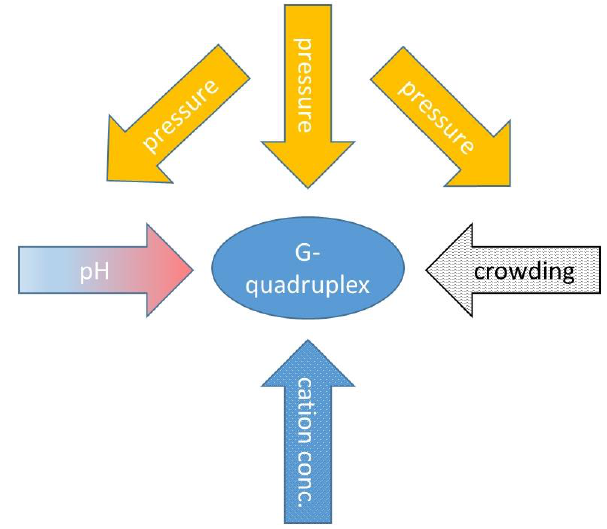
Figure 5. Complexity of the direct and indirect pressure effects in case of GQ.